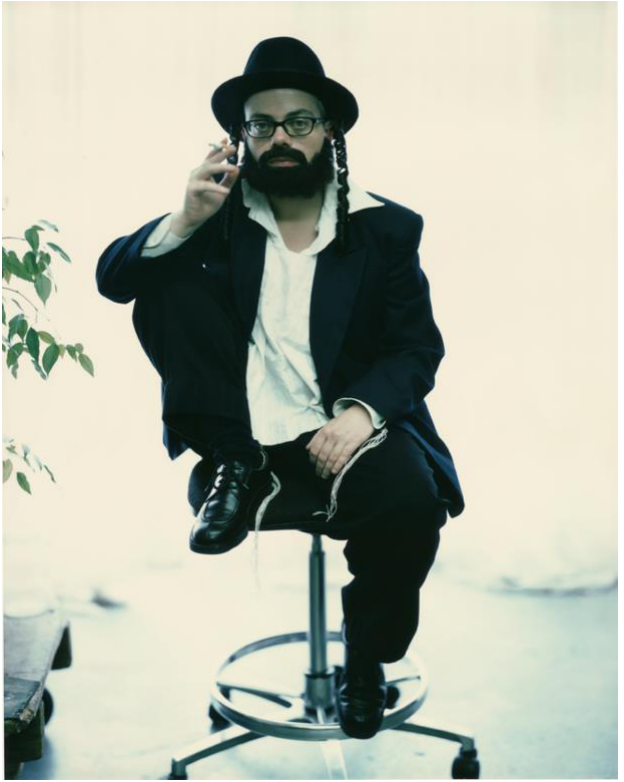
Figure 1. Oreet Ashery, Self Portrait as Marcus Fisher I , 2000, original 25.4 × 20 cm; Polaroid scanned to lambda prints, 100 × 110 cm. Photograph by Manuel Vason. Courtesy of the artist.